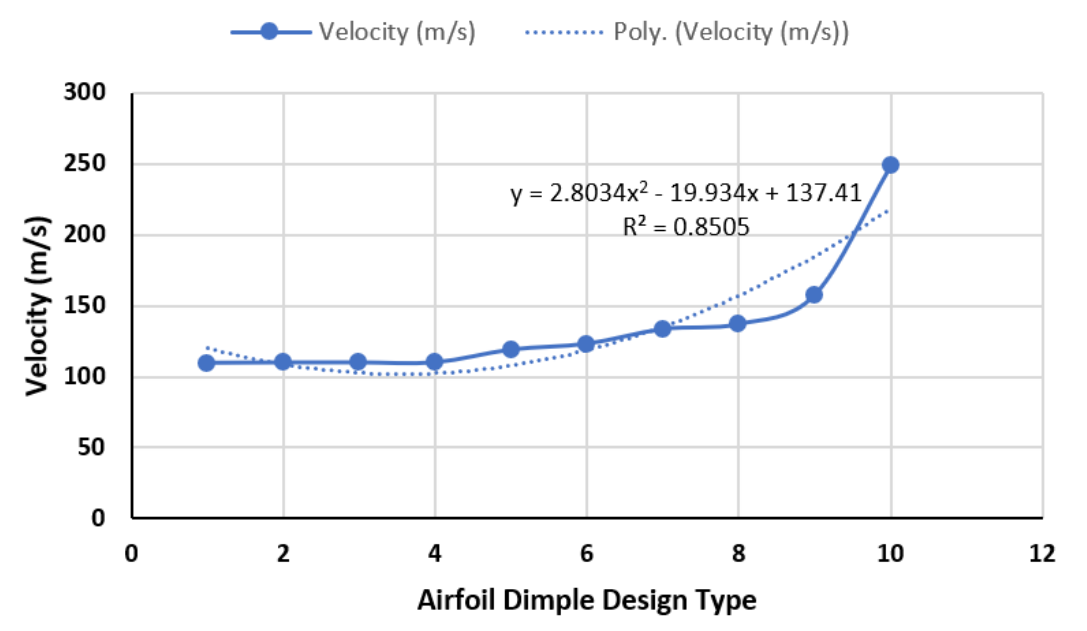
Figure 20. The velocity plot for the 10 dimple aerofoil designs.